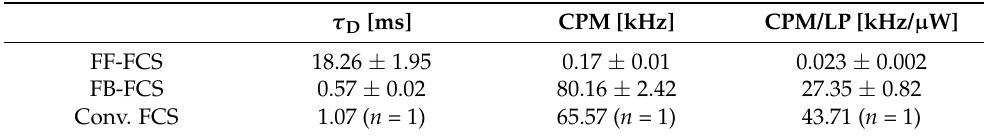
Table A1. Measurement results of fluorescent latex beads. The values show mean ± standard error ( n = 3). Conv. FCS denotes the conventional FCS